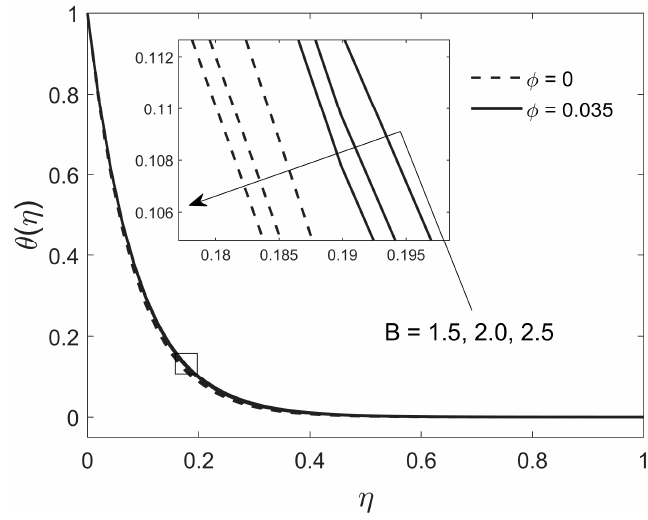
Figure 13. Effect of curvature on the temperature distribution.